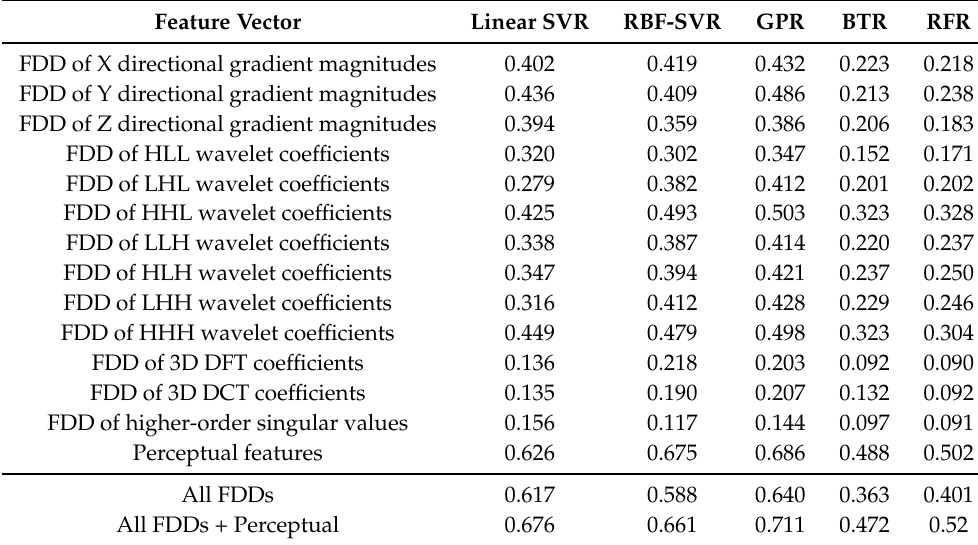
Table 11. Performance comparison of the FDD and perceptual feature vectors on KoNViD-1k [22]. Median SROCC values were measured over 1000 random train–test splits on KoNViD-1k [22]. Feature Vector Linear SVR RBF-SVR GPR BTR RFR FDD of X directional gradient magnitudes 0.402 0.419 0.432 0.223 0.218 FDD of Y directional gradient magnitudes 0.436 0.409 0.486 0.213 0.238 FDD of Z directional gradient